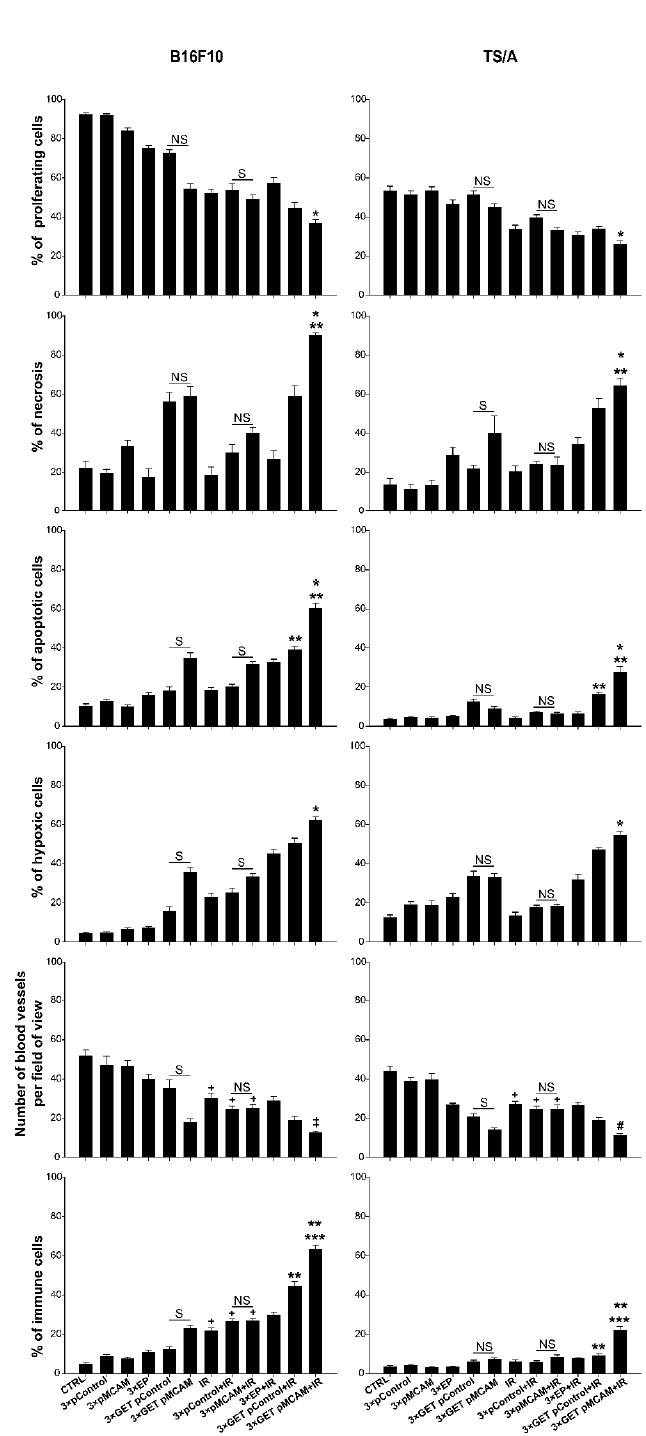
Figure 5. Histological analyses of B16F10 melanoma and TS / A carcinoma after gene electrotransfer (GET) with plasmid-encoding shRNA against MCAM (pMCAM) and single-dose irradiation (15 Gy). The data represent the arithmetic mean and standard error of the mean, n = 10 analyzed fields of view. p < 0.05 considered for statistically significant di ff erence; NS: statistically non-significant di ff erence between the therapeutic groups; S: statistically significant di ff erence between the therapeutic groups; * compared to control and monotherapy groups; ** between tumor models; *** compared to all other groups; # compared to all groups except to GET pMCAM; ‡ compared to all groups except GET pMCAM and GET pControl + IR; + compared to the CTRL, pMCAM, and pControl